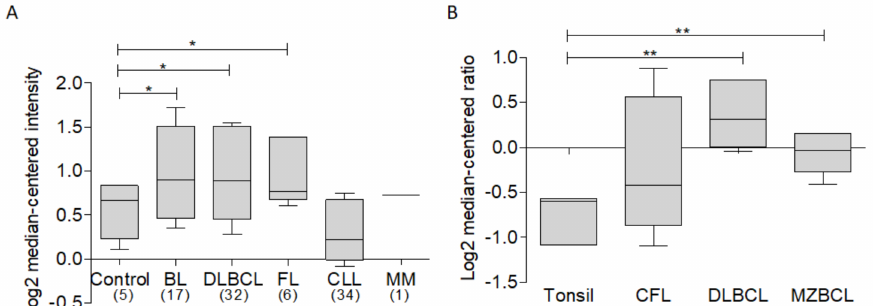
Figure 3. Analysis of BCL-xL expression in hematological malignancies. Bioinformatic analysis of BCL-xL expression was revised in ONCOMINE data base using different datasets (* p < 0.05). ( A ) The analysis of Basso et al. [29] of BCL-xL expression in different hematological malignancies including subtypes of lymphoma, leukemia, and multiple myeloma. ( B ) In Storz et al. [30], we observe higher expression levels of BCL-xL expression in DLBCL and MZBCL vs. tonsil used as a control (** p < 0.01).